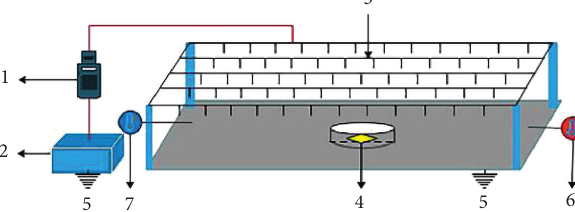
Figure 1: Electrohydrodynamic drying system. 1: high-voltage power source; 2: control system; 3: needle electrode; 4: sample; 5: ground electrode; 6: thermometer; 7: hygrometer.